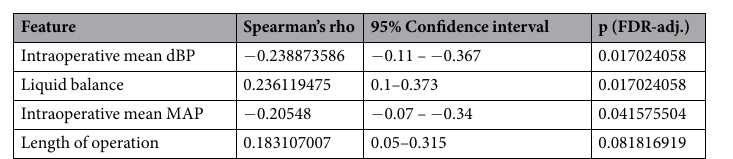
Table 2. Spearman’s correlation coefficient rho, its bootstrapped 95% confidence interval and false discover rate-adjusted p value for mean intraoperative dBP, mean intraoperative MAP, liquid balance and length of